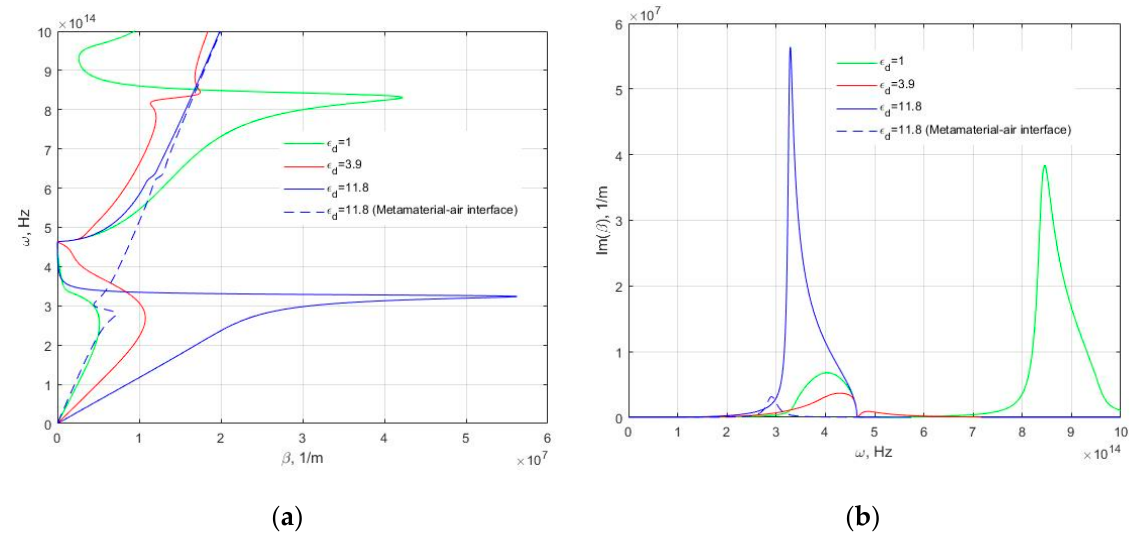
Figure 4. Dependences of the real ( a ) and imaginary ( b ) parts of the propagation constant versus frequency for the instance of the nanowire composite interface, if ω c / ω p = 1, d = 30 nm, S = 70 nm.